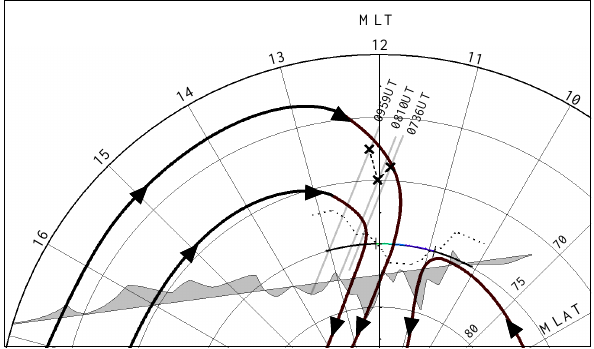
Fig. 9. Composite dial plot for comparison of observations by the different instruments in the geomagnetic reference frame. It shows the locus of the ESR observations near 75 ◦ N, the equatorward edge of the red-line emission observed by the MSP, the cross-trajectory horizontal flows measured by the F13 DMSP satellite, anticipated plasma flow lines for the pertinent IMF conditions, and the 300km intersections of the three tomography passes indicating the location of the maximum density of the sub-auroral enhancement. For a detailed description the reader is referred to the